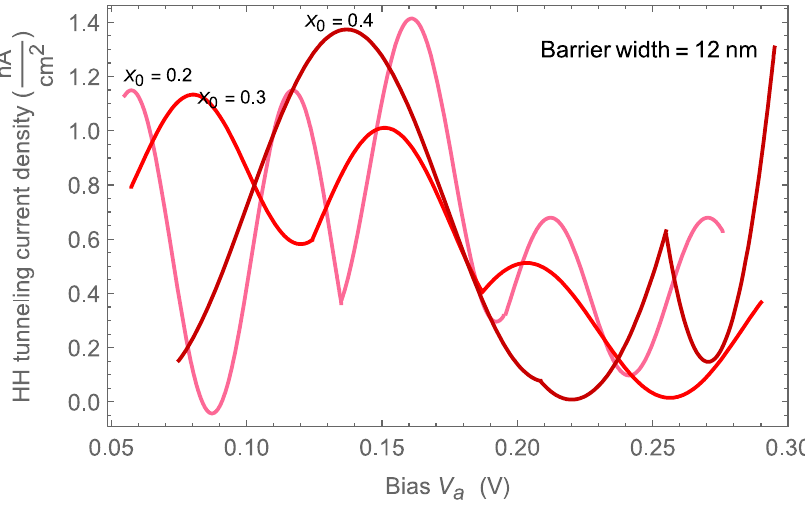
Figure 15. Current density-voltage characteristics of the HH tunneling at width barrier 12 nm.